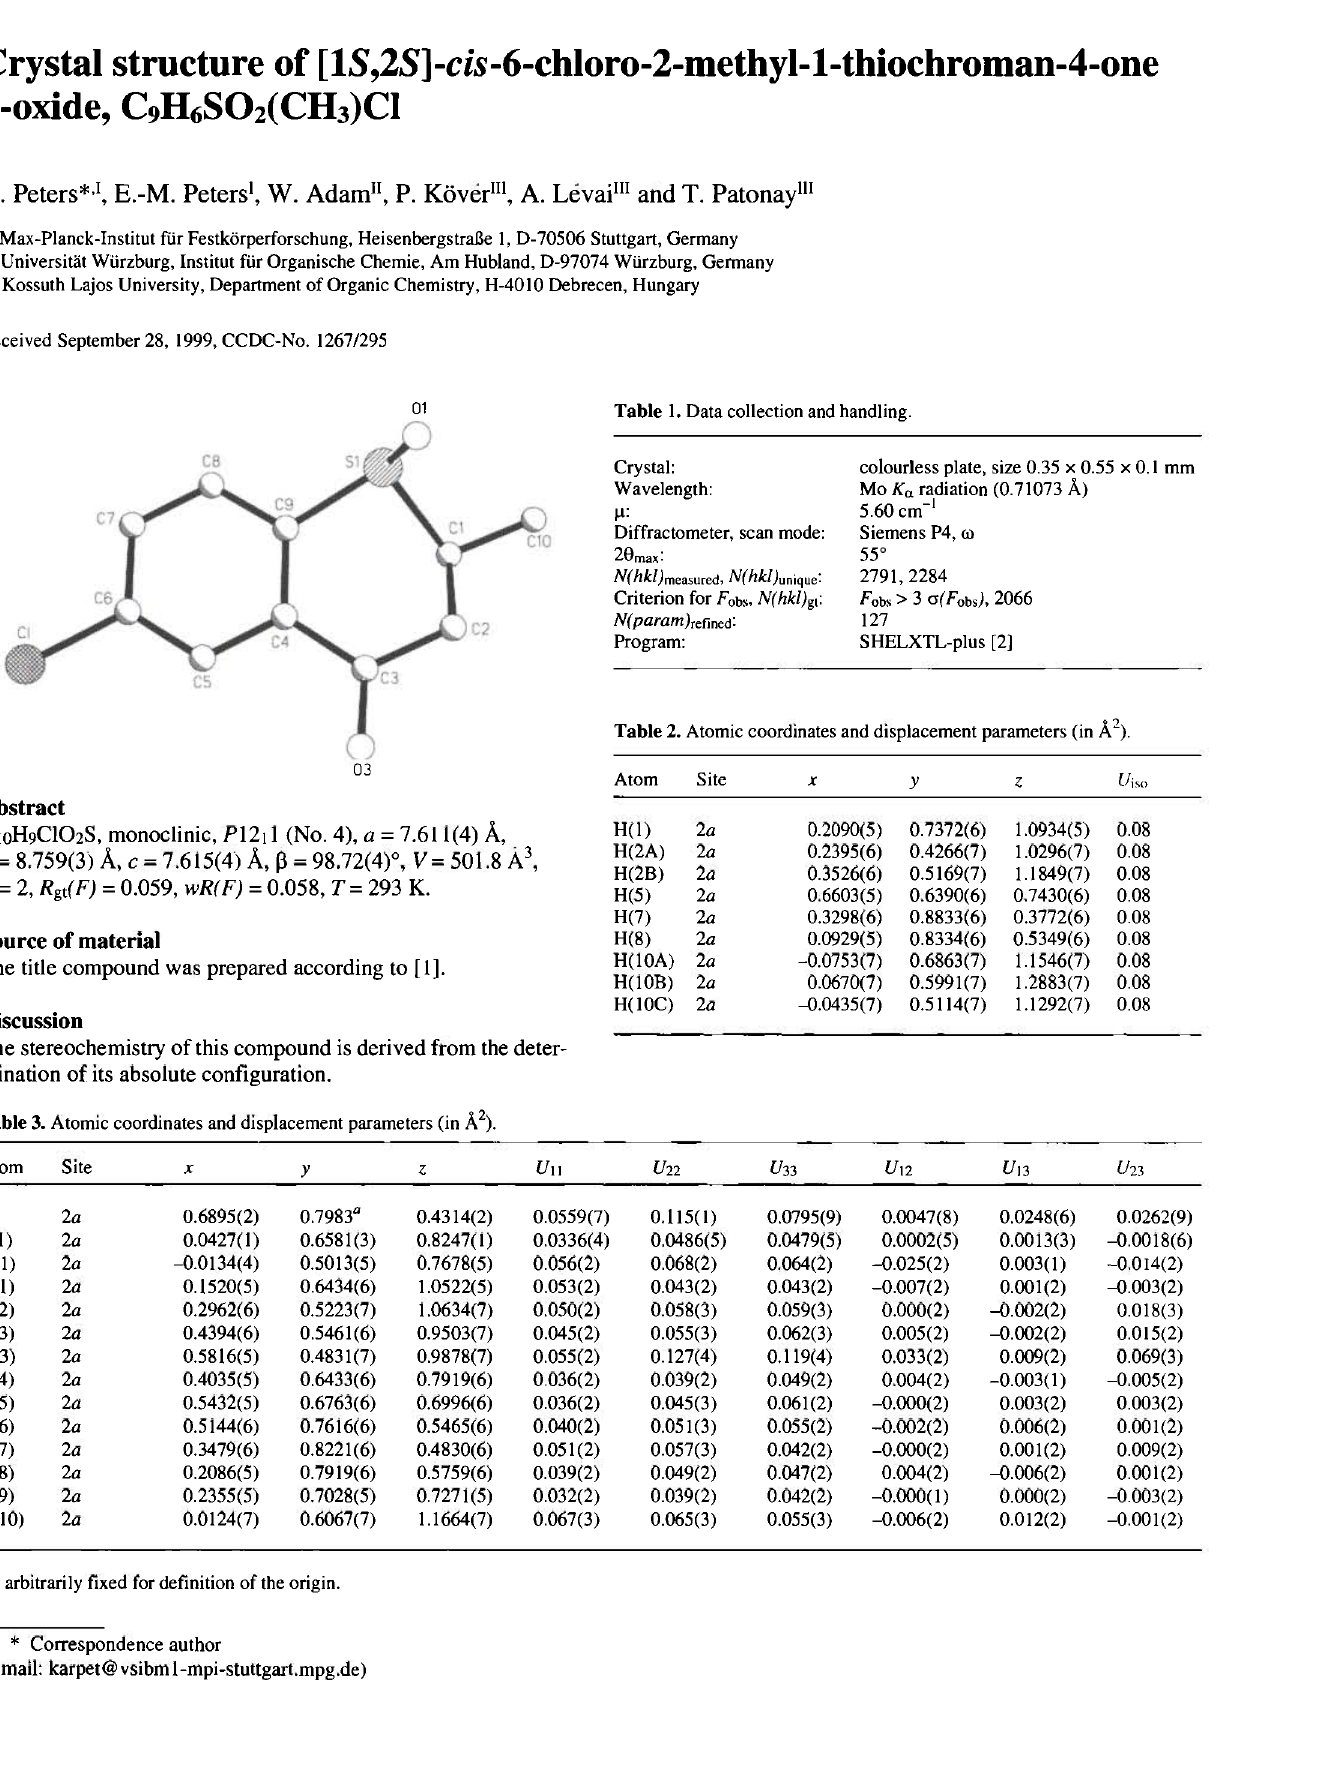
Table 1. Data collection and handling. Crystal: